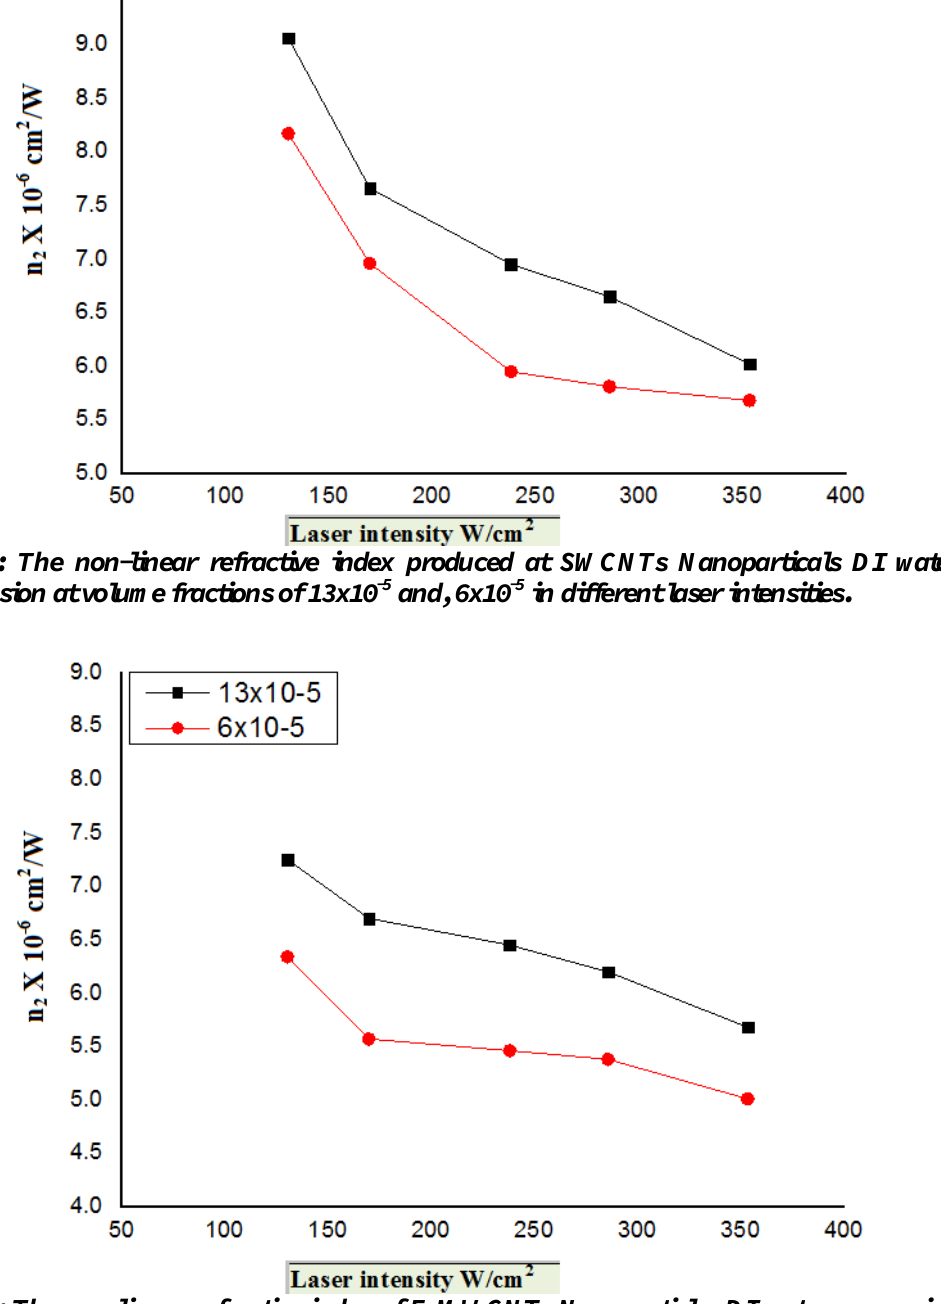
Fig.12: The non-linear refractive index of F-MWCNTs Nanoparticles DI water suspension at volume fraction of 13X10 -5 , and 6X10 -5 in different